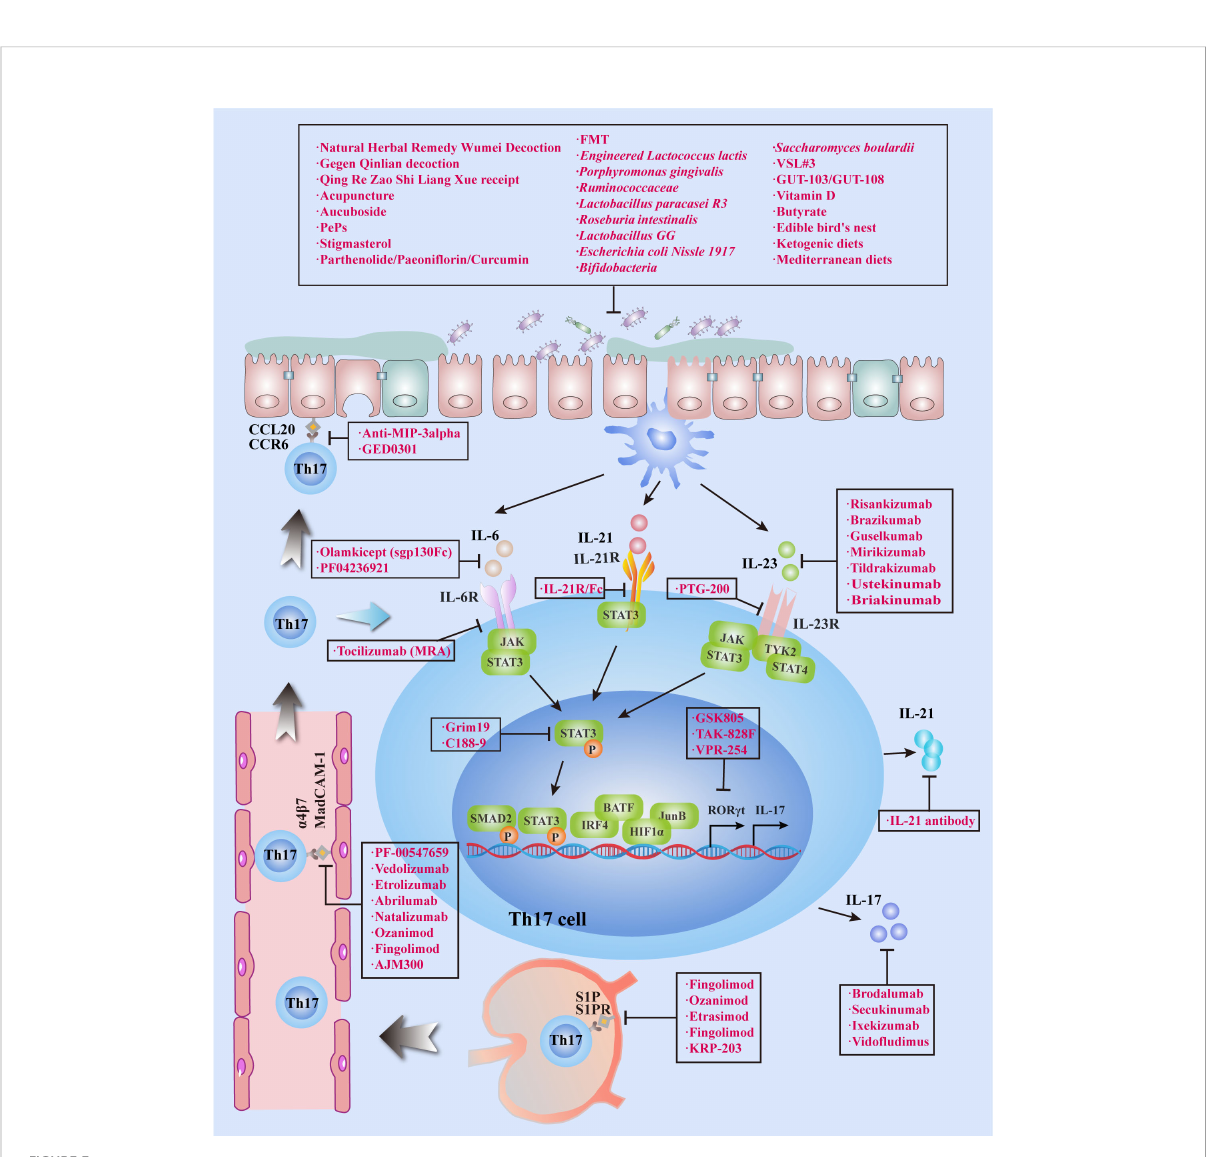
FIGURE 3 Targeting Th17 cells for treat IBD. IBD can be treated by inhibiting Th17 cell migration, in fi ltration, differentiation and secretion of cytokines. In addition to conventional treatment methods, medicine or phytochemicals, FMT and probiotics can also inhibit Th17 cell differentiation and IL-17 expression by regulating the bacterial fl ora, which eventually leads to clinical remission of